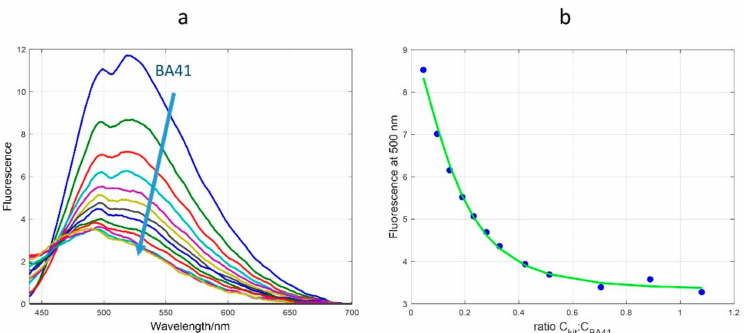
Figure 4. ( a ) Fluorescence spectra recorded along the titration of BA-41 ( 2 ) with c-kit21T12T21. Original fluorescence signal at 500 nm for the titration of BA-41 ( 2 ) at di ff erent concentrations of c-KIT ( b